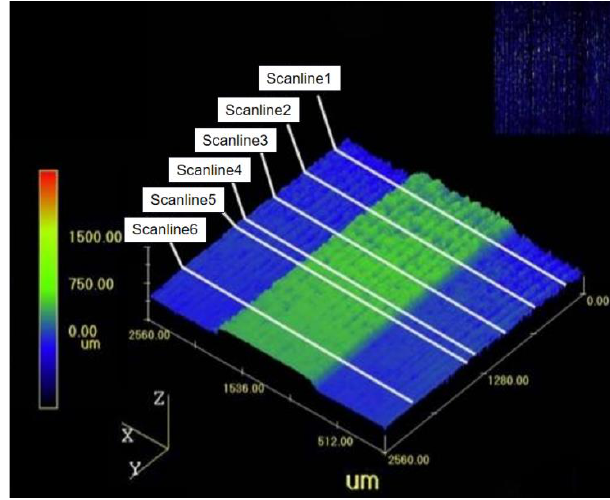
Figure 8. Laser confocal scanning 3D morphology.